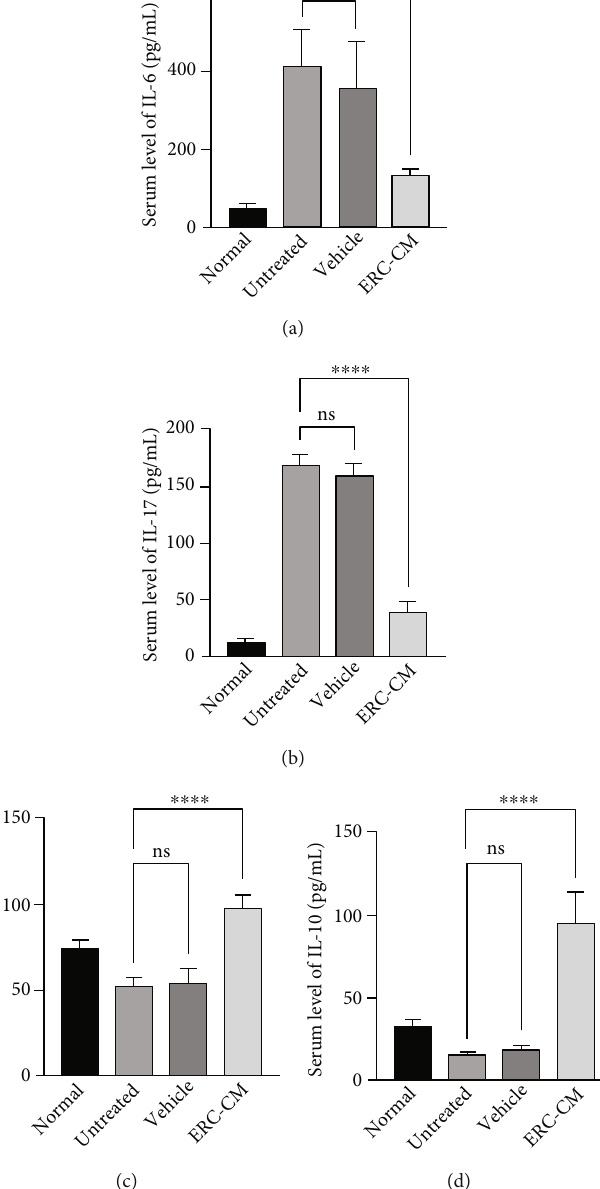
Figure 7: ERC-CM modulated the cytokine level in sera. Measurement of serum levels of IL-10, IL-27, IL-17, and IL-6 using the appropriate ELISA kits. IL-6 (a), IL-17 (b), IL-27 (c), and IL-10 (d) were shown, respectively. The p value was determined by one-way ANOVA. ∗ p < 0 : 05 , ∗∗ p < 0 : 01 , ∗∗∗ p < 0 : 001 , and ∗∗∗∗ p < 0 : 0001